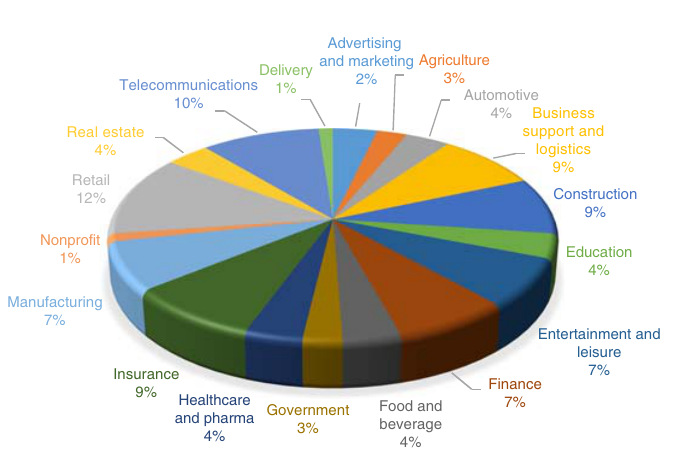
Table II. Profile of the 81